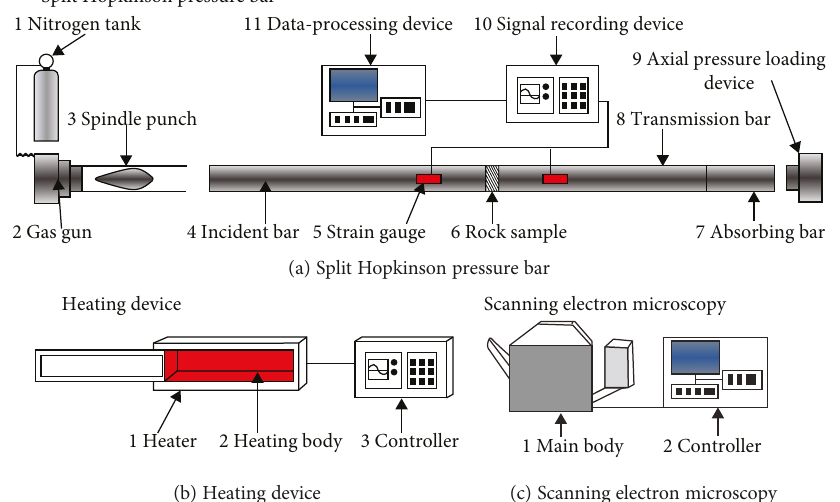
Figure 2: The main apparatus: (a) split Hopkinson pressure bar (SHPB); (b) variable-speed heating furnace; (c) scanning electron microscopy (SEM).